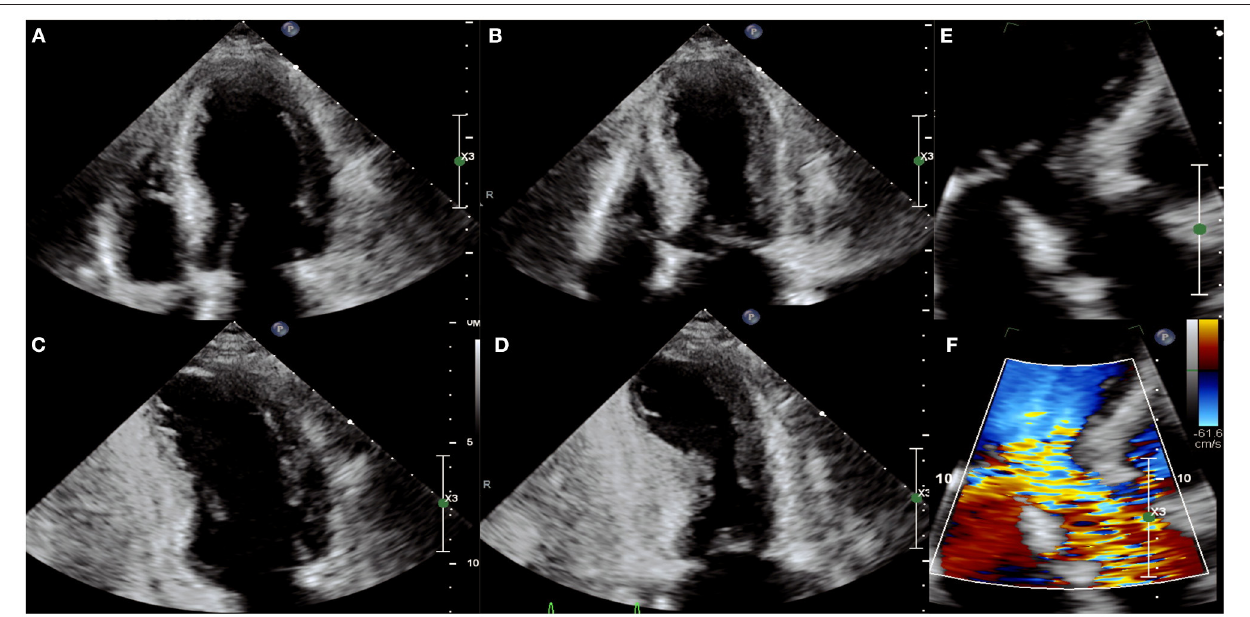
FIGURE 1 | Echocardiographic images of a person with stress cardiomyopathy with left ventricular outflow track obstruction (LVOT) and systolic anterior motion (SAM) of the mitral valve. The apical-4-chamber view in diastole (A) and systole (B) and 2-chamber view in diastole (C) and systole (D) showing classic apical ballooning with akinesis and hyperdynamic basal segments. (E,F) Illustrate SAM and turbulence across the LVOT indicative of LVOT